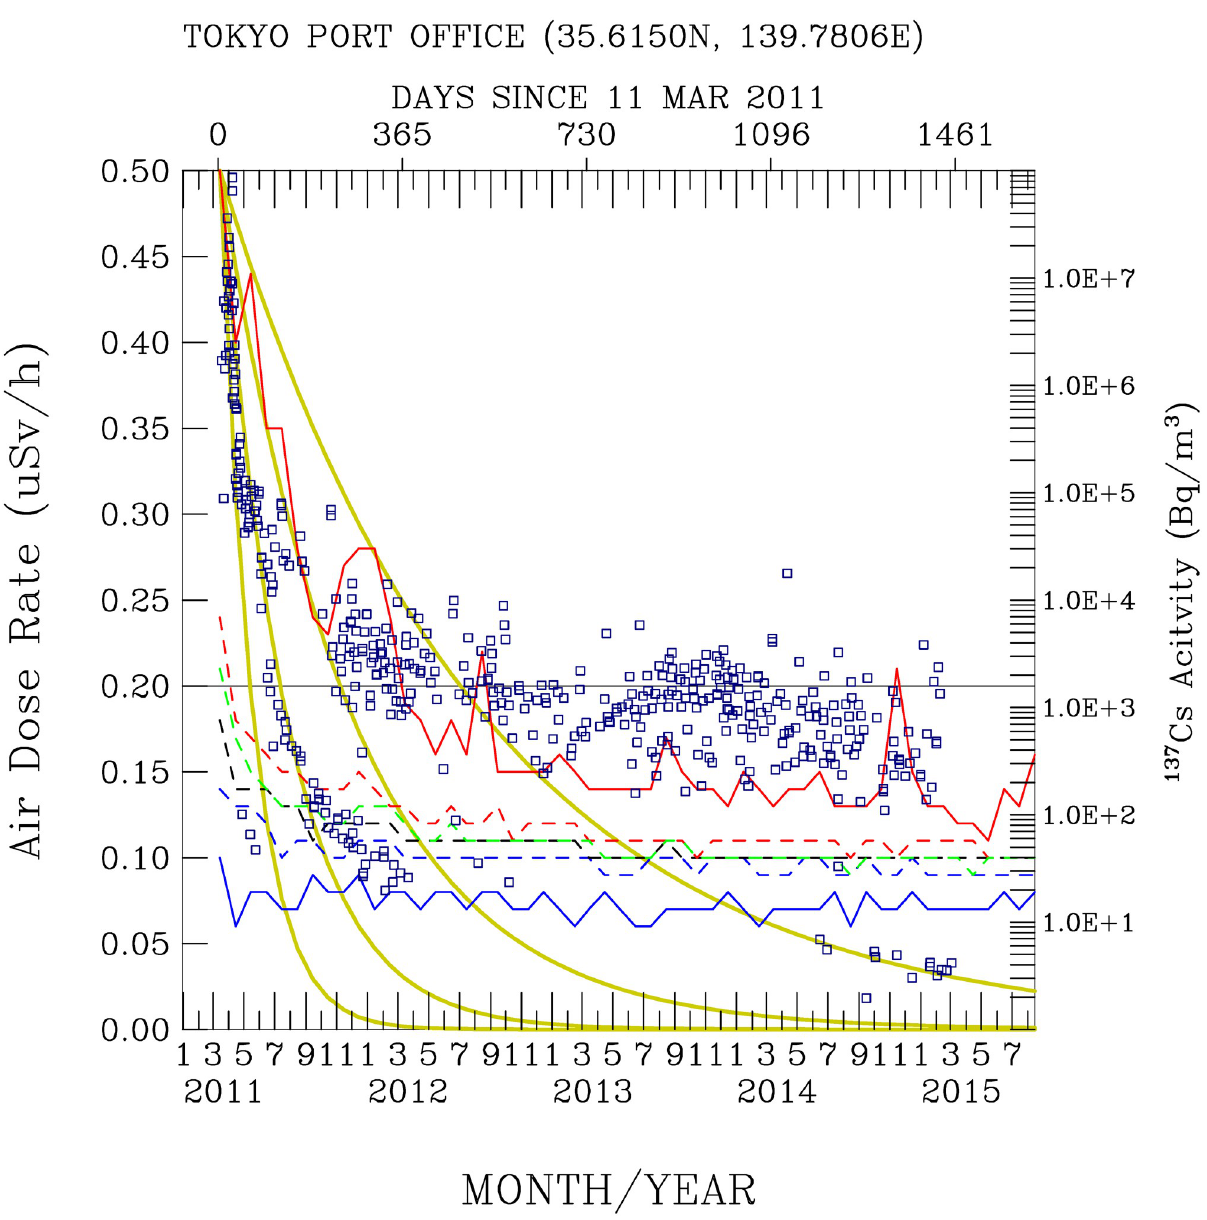
Fig 10. Comparisons of radioactivity measured at the Port of Tokyo with the radioactive nuclei 137 Cs measured (blue squares, Bq/ m 3 ) in a drainage by Aoyame et al. [9]. Red solid, red dashed, green dashed, black dashed, blue dashed, and blue solid lines indicate the maximum, 75 th , 50 th , mean, 25 th , and minimum air dose rates measured at the Port of Tokyo. For reference, the yellow curves show the analytical distribution of the time- series air dose rates calculated with half-lives of 45, 90, 180, and 360